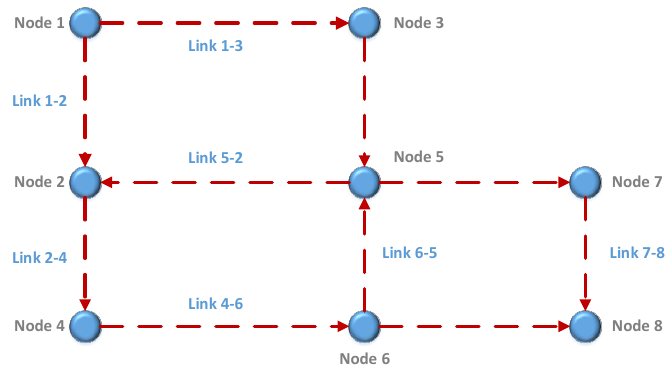
Figure 4. Example of a trajectories graph expressed abstractly as a topological map. This map also includes the metric information. Each node represents the location of roads intersections, and each link contains a series of points in 2D Cartesian coordinates that will serve as local goals to the